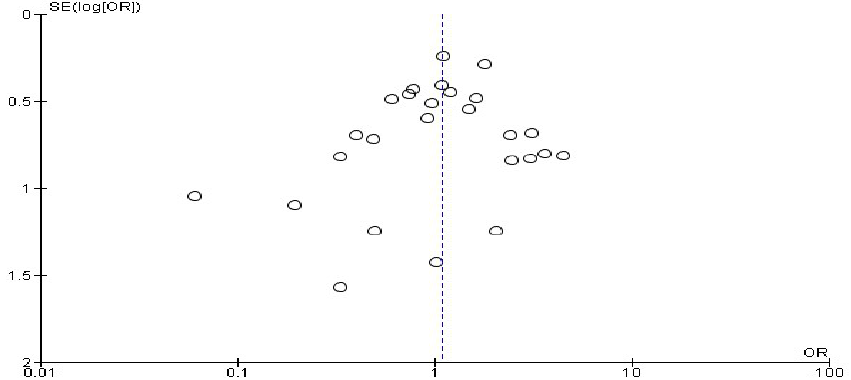
Figure 6. Funnel plot (surgical site infections rate).